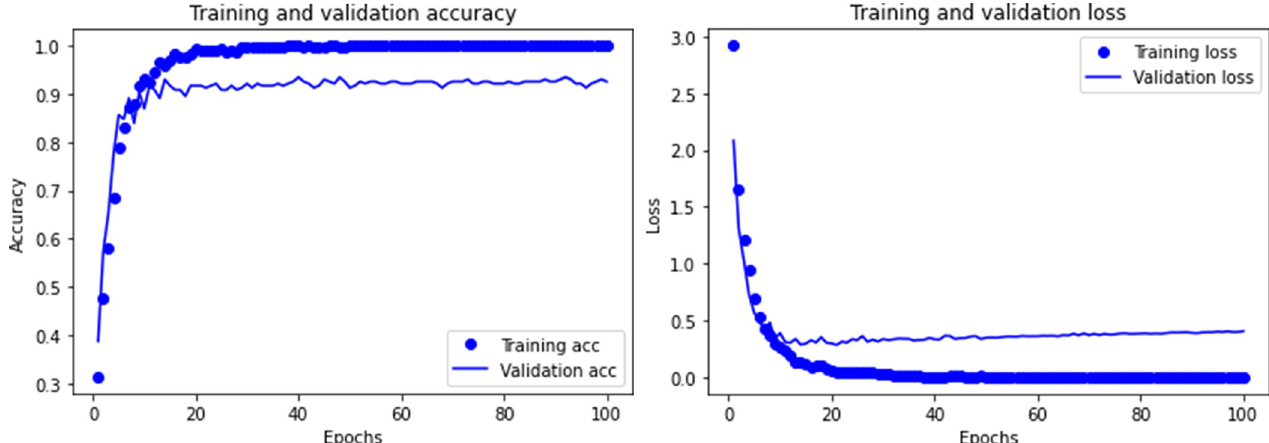
Fig 6. Accuracy and loss of CNN model when training 100